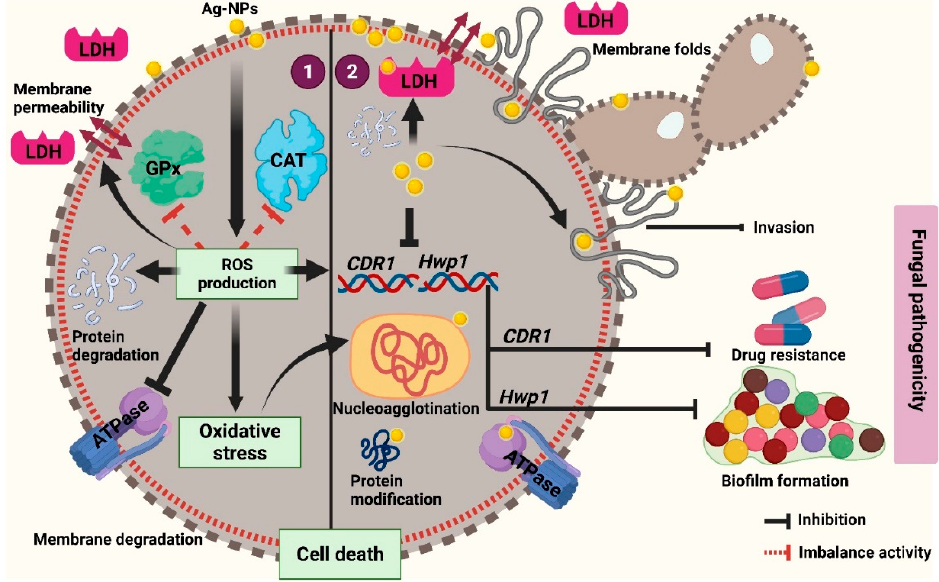
Figure 9. Schematic diagram illustrating the possible mechanism of D-SNPs and N-SNPs (Ag-NPs) against C. albicans